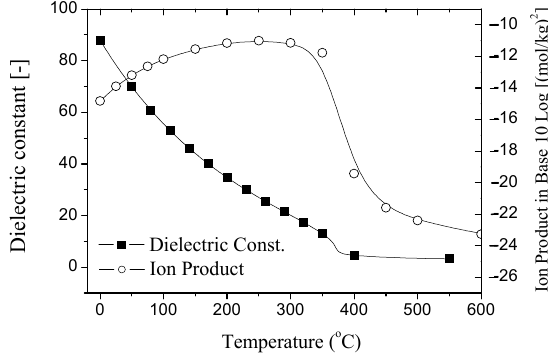
Figure 1. Dielectric constant and ionic products of water at sub-critical state.